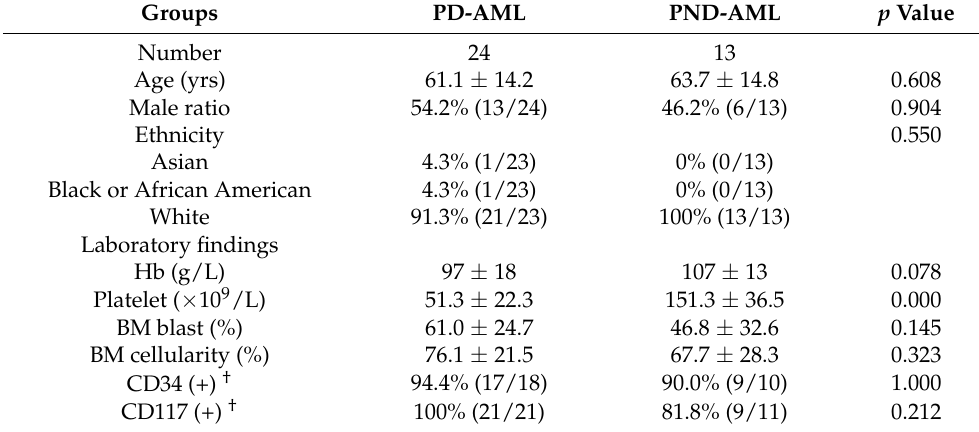
Table 1. Characteristics of NK-AML patients from platelet-decreased group (PD-AML; platelet count < 100 × 10 9 /L) and platelet-not decreased group (PND-AML; platelet count ≥ 100 × 10 9